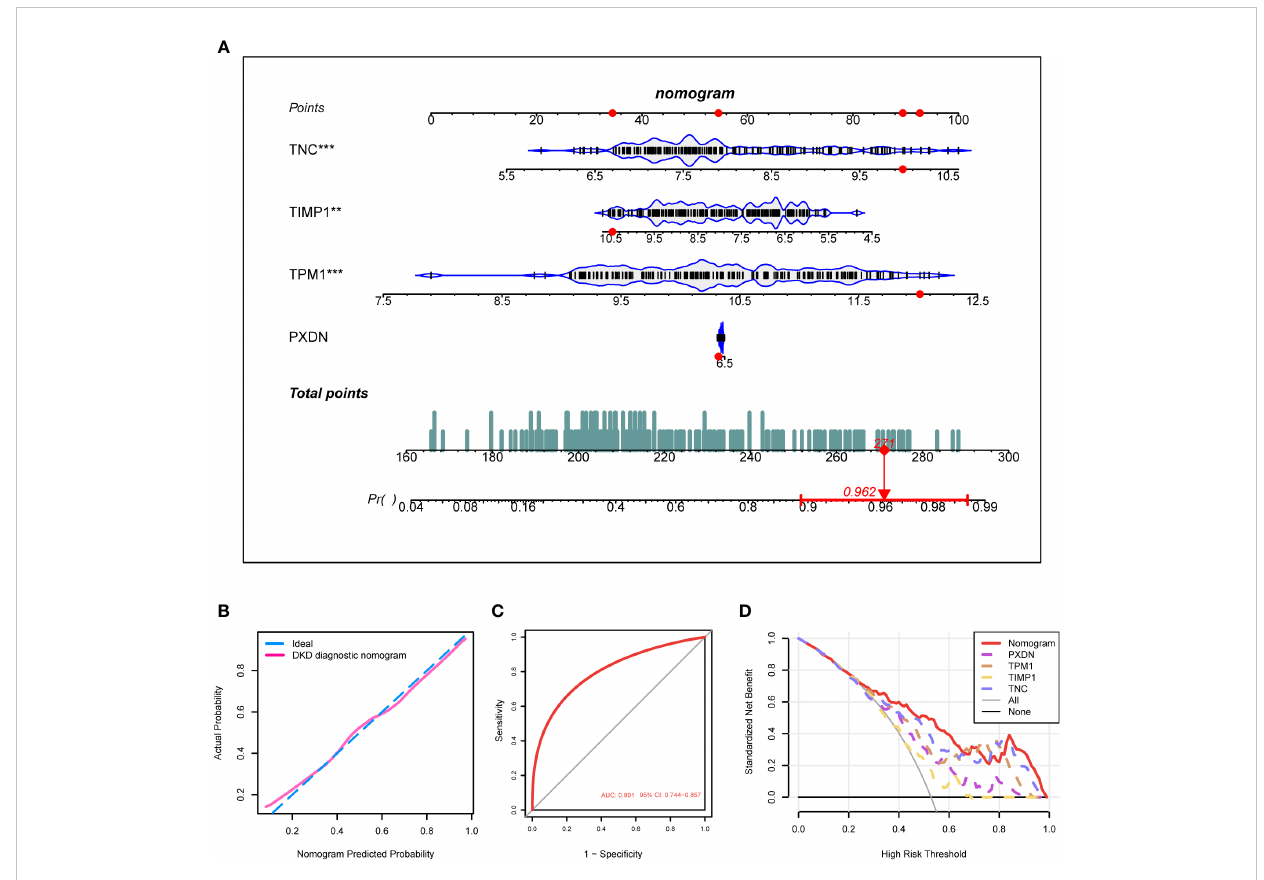
FIGURE 6 Construction of the DKD diagnostic model. (A) Nomogram of the DKD diagnostic model on the basis of 4 diagnostic markers. (B, C) The calibration (B) and ROC curves (C) were used to evaluate the diagnostic ef fi cacy of the DKD diagnostic nomogram. (D) DCA illustrating the NB assessing